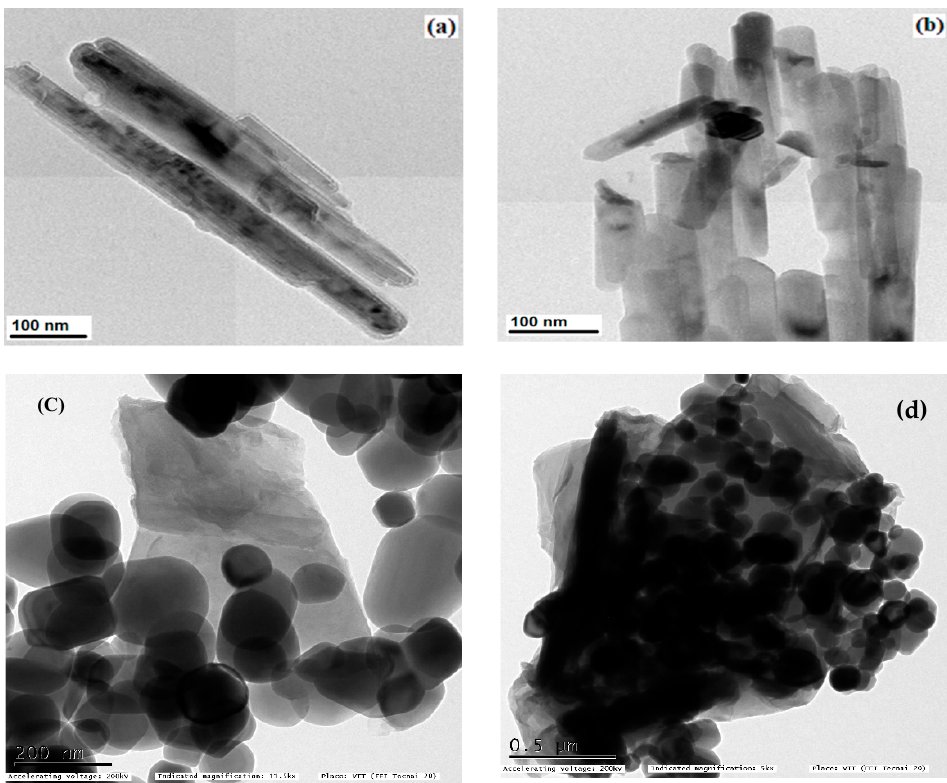
Figure 2. ( a , b ) HRTEM images of TiO 2 nanospheres. ( c , d ) HRTEM images of rGO/TiO 2 nanocomposites at two different sites at two different magnifications.